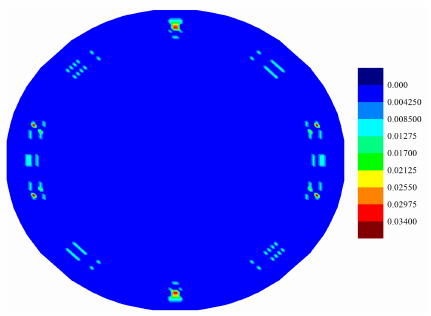
Figure 20. Interlayer shear damage of middle ply in coupled case at 0.3461 × 10 − 3 s.